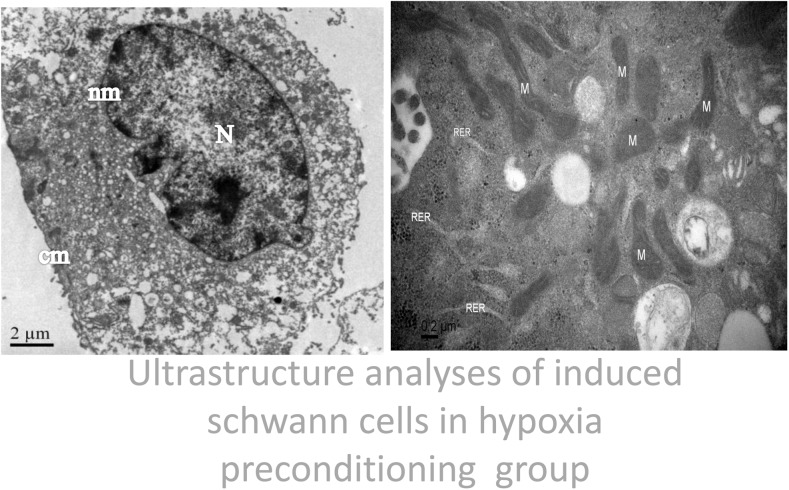
Images from the hypoxia-preconditioning group reveal cell swelling, no obvious cell membrane disintegration, no obvious swelling of mitochondria, mitochondrial cristae with clear and complete structures, Rough endoplasmic reticulum is not dilated, partial nucleolus shrinkage, nuclear membrane integrity.M: mitochondria RER:rough endoplasmic reticulum N:nucleolus, nm: nuclear membrane, cm: cell membrane.